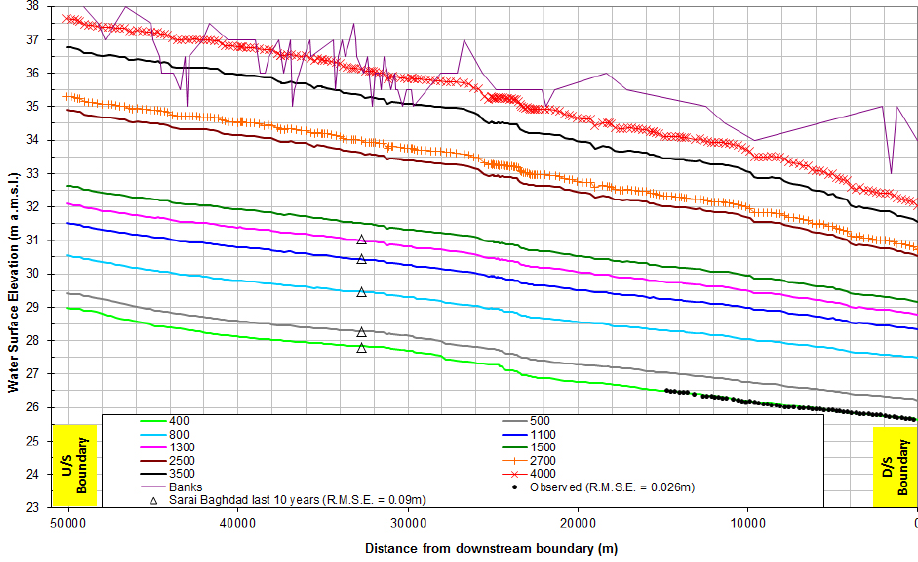
Fig. 12. Computed water surface elevations for different discharge in Tigris and Diyala Rivers with discharge of 5m 3 s − 1 with calibration and verification data.